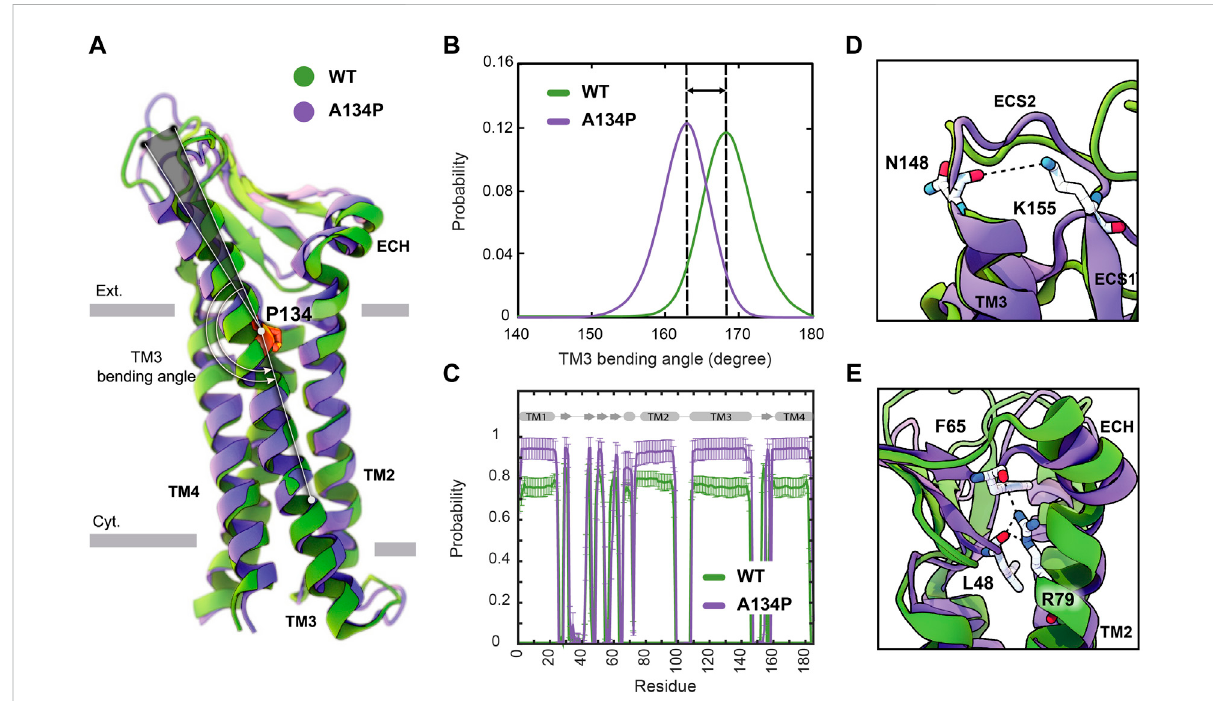
FIGURE 3 A134P mutation results in the bending of TM3. (A) Superposition of WT and A134P mutant claudin-15 monomers exhibits the bent structure of TM3 after A134P mutation. Gray bars suggest boundaries of the outer (Ext.) and inner (Cyt.) lea fl ets of the lipid bilayer. (B) TM3 bending angle for the WT and A134Pmutantmonomers is calculated over the last 100 ns ofthe simulation trajectories of single-layer strands. (C) The secondarystructure of helices and β -strands in WT and A134P monomers show structural stability of the monomers over the last 250ns of simulation time. Key interactions within each monomer, in the form of (D) a salt bridge between N148 and K155 stabilizes the structure of ECS2, and (E) interactions between the backbone of F65 and L48 β -strands and side chain of R79 on TM2 stabilize the β -sheets and orientation of ECH. These interactions are maintained in mutant monomers (shown in purple) similar to WT monomers (shown in